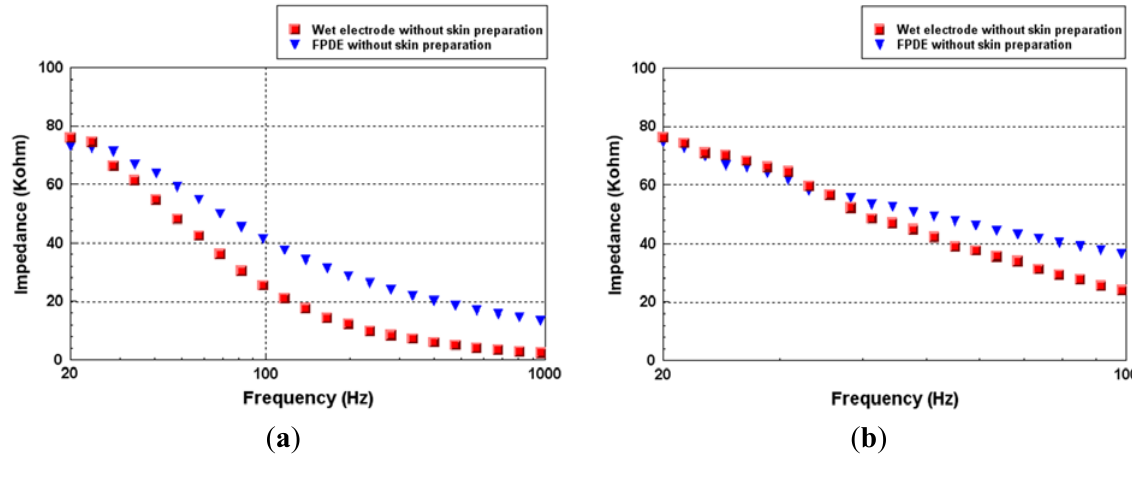
Figure 7. Impedance of the FPDE (contact area:27.3 mm 2 ) and wet electrodes (contact area:314.2 mm 2 ) at ( a ) 20 to 1 kHz and ( b ) 20 to 100